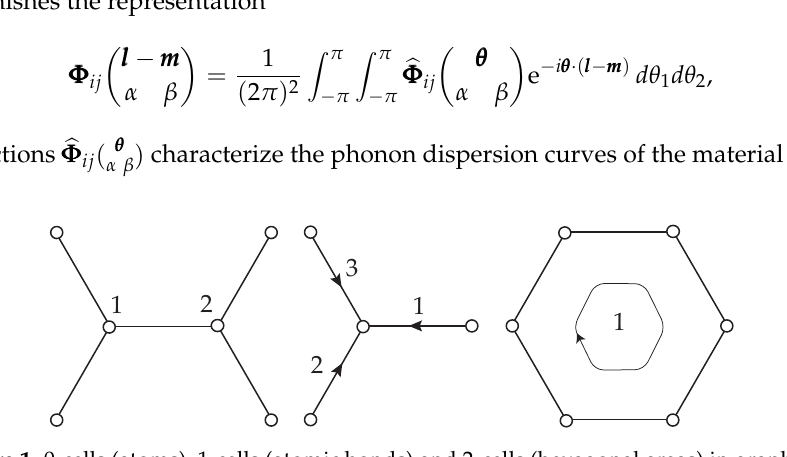
Figure 1. 0-cells (atoms), 1-cells (atomic bonds) and 2-cells (hexagonal areas) in graphene.